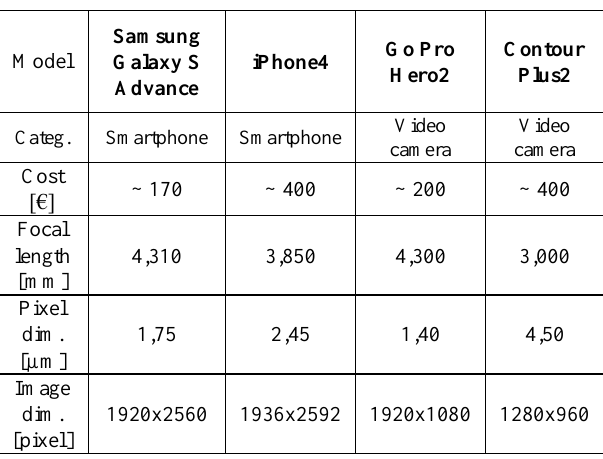
Table 1. Devices and their principal